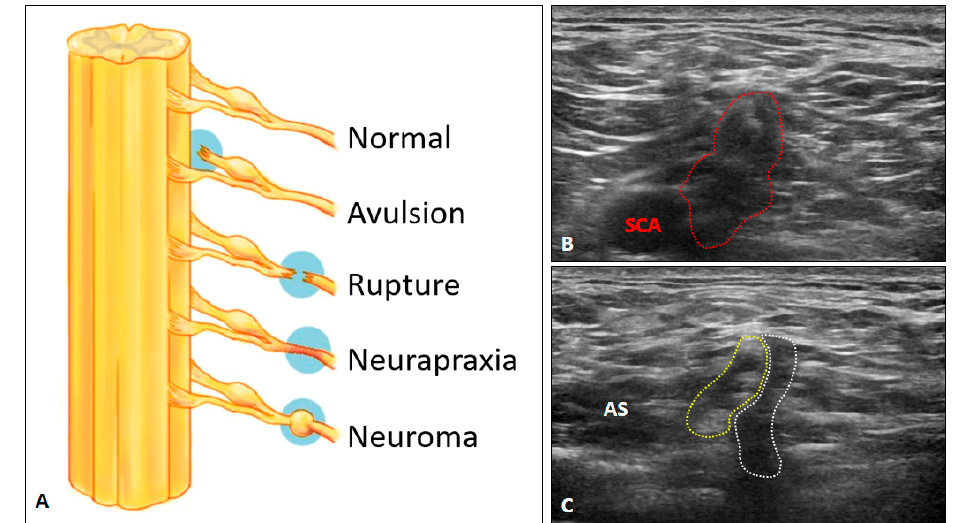
Figure 14. Schematic drawing of different types of nerve injury ( A ). Ultrasound imaging of chronic traumatic brachial plexus injury: a neuroma (red dashed area) ( B ) and tethered brachial plexus (yellow dashed area) besides the scar (white dashed area) ( C ). AS: anterior scalene muscle; SCA, subclavian artery.